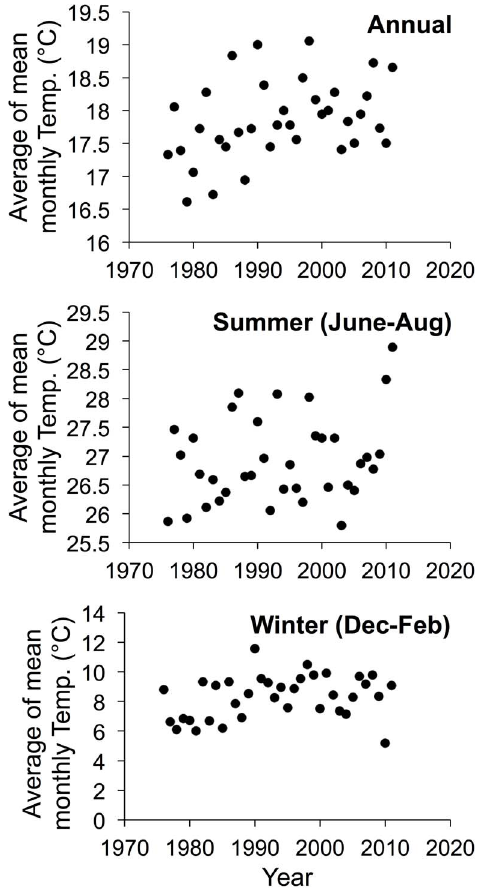
Figure 1. Annual, summer, and winter mean monthly temper- atures near the Savannah River Site (South Carolina, United States) from 1976 to 2011.